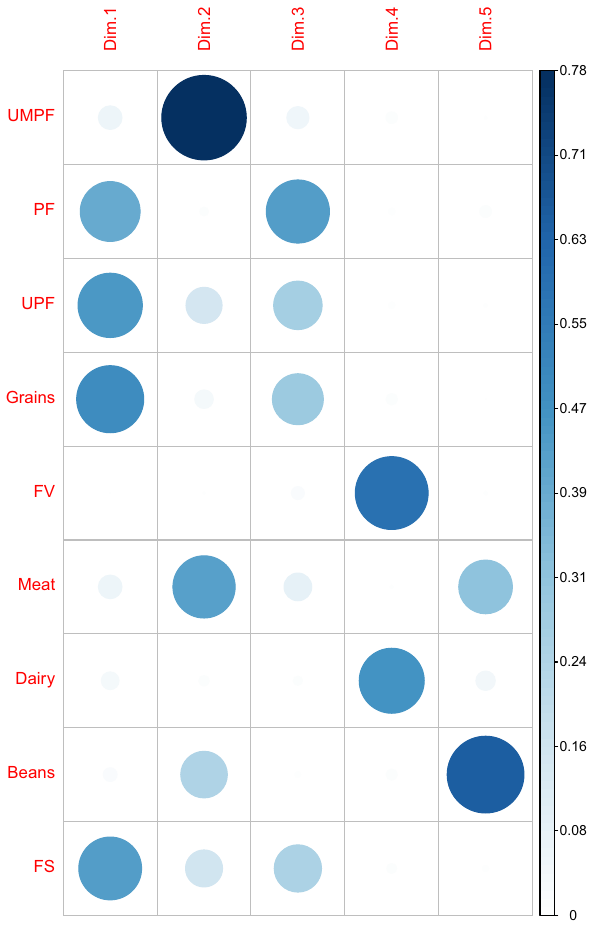
Figure 3. Food groups best represented in correlations of each of the five dimensions of dietary patterns. The image shows the representation of the variables loads for each component on gradual colours white to dark blue (between 0 and 0.78% on the scale). Image obtained from the R software. UMPF Unprocessed and minimally processed food, PF processed food, UPF ultra-processed food, FV fruits and vegetables, Meat meat and eggs, FS fats and